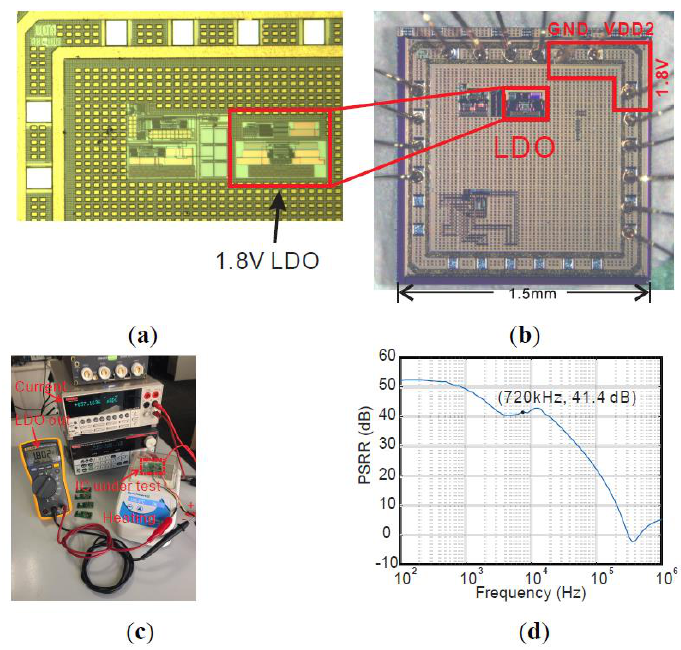
Figure 9. ( a ) Micrograph of the previously fabricated 1.8 V LDO in 180 nm XH018 technology. ( b ) Directly wire-bonded die on a gold pad PCB. ( c ) 1.8 V LDO test setup. ( d ) Measured power supply rejection ratio (PSRR) of 1.8 V LDO with a 0.1 µF capacitor load.